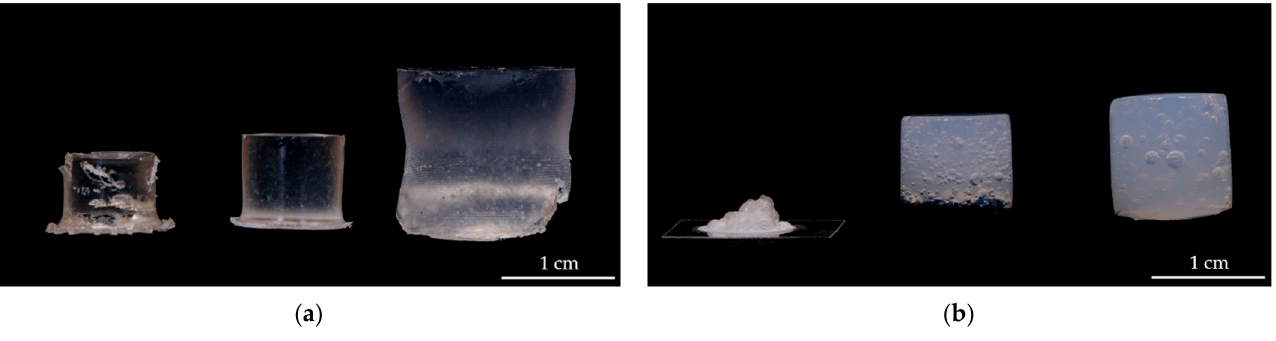
Figure 5. Comparison of the ( a ) synthesized hydrogels (MASO 3 2 mol/L, BAP 2 mol%) and the ( b ) ChondroFiller ® liquid biomaterial in the dried, freshly synthesized, and swollen state.